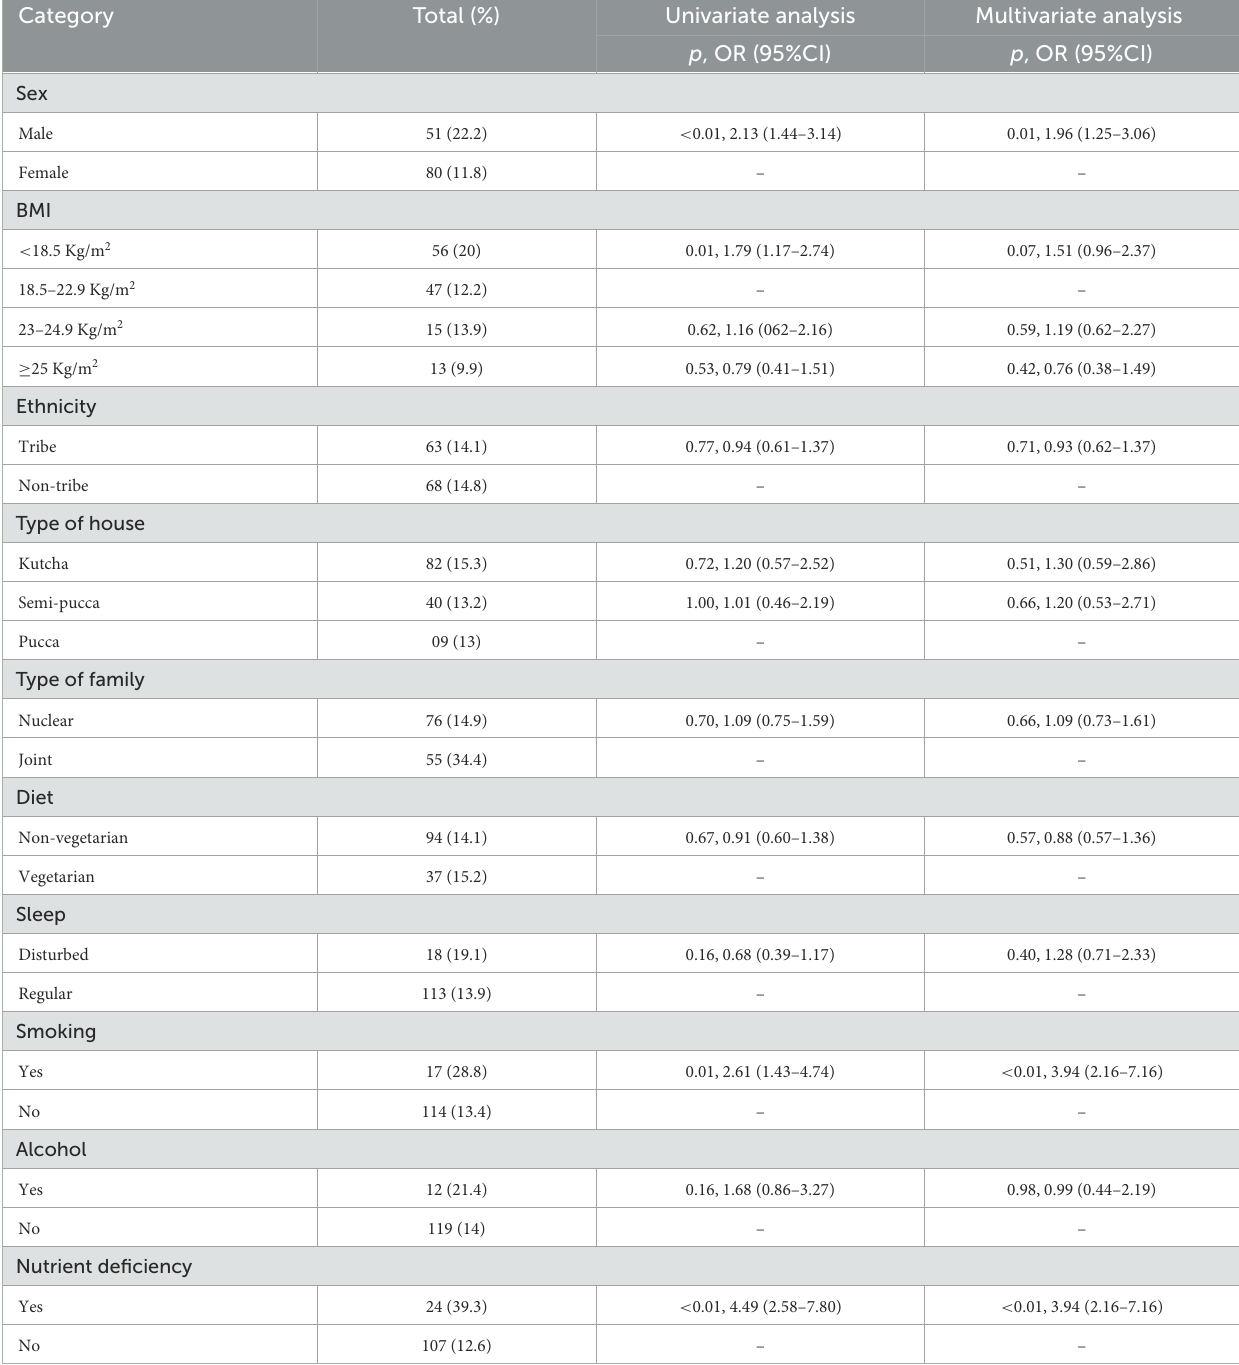
TABLE 3 Risk factors associated with the communicable disease among study participants.